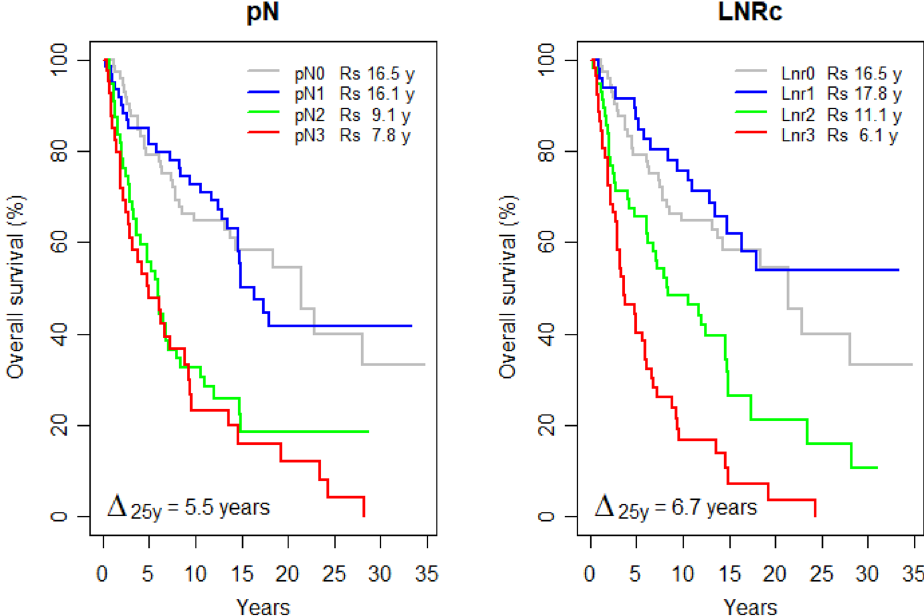
Figure 3. Survival according to nodal quanta classes. Rs, restricted mean survival time (RMST) at 25 years time horizon. Δ 25y , Gini’s mean difference of the RMSTs.